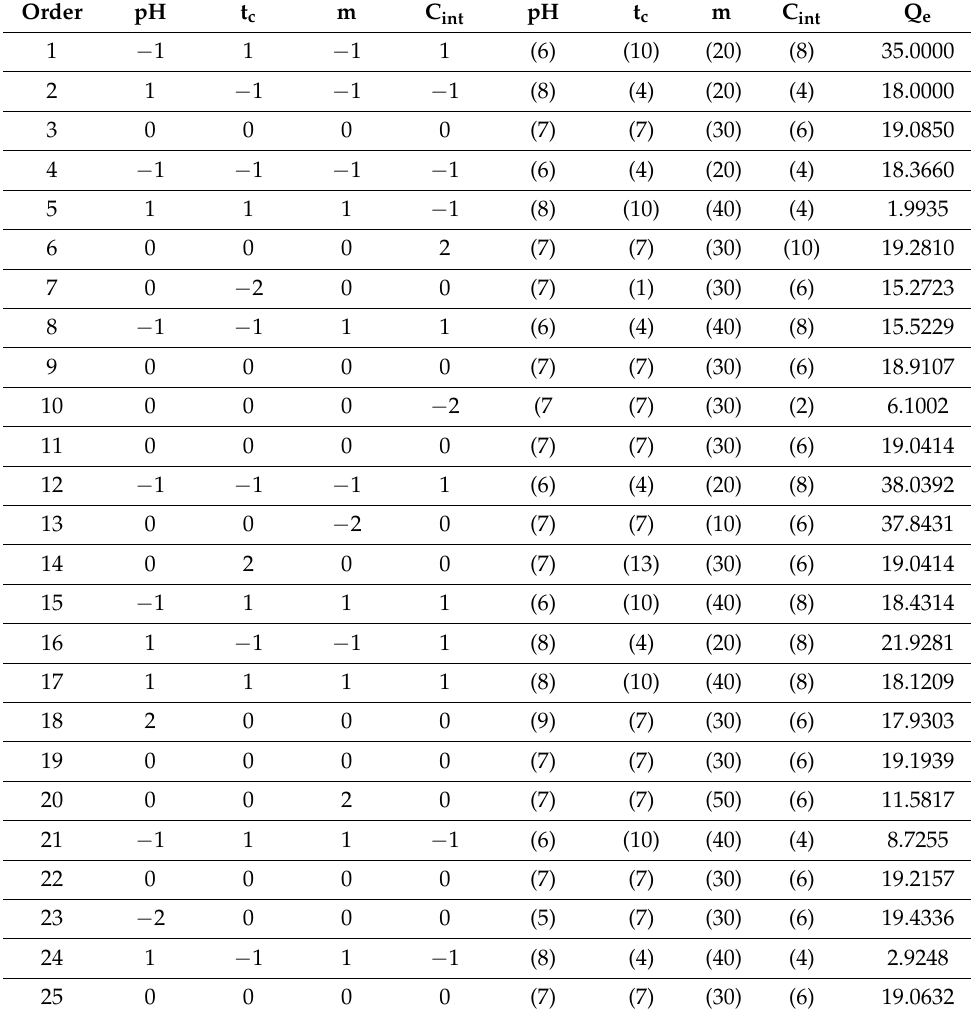
Table 3. Experimental design of the optimization of the PCP adsorption capacity on the Mt-Fe-CATB with the responses recorded for each